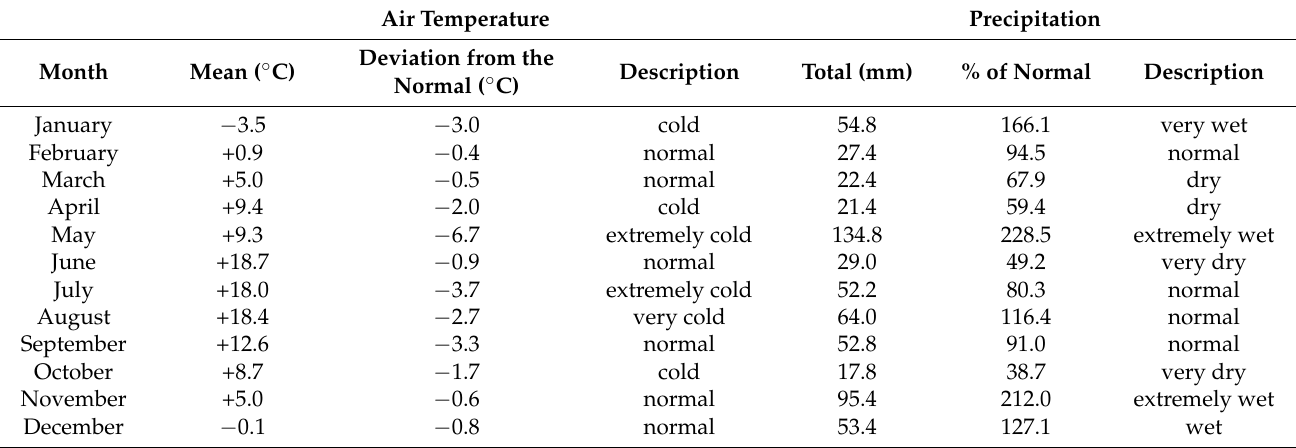
Table 1. Evaluation of monthly precipitation and mean air temperature in 2019 compared with the 30-year climatic normal (1991–2020).